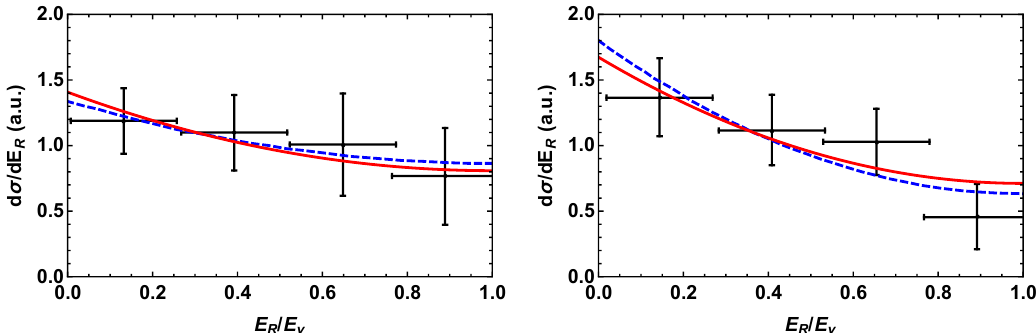
Figure 2 . The differential cross sections of the ν µ (left) and ¯ ν µ (right) scattering on electrons at CHARM-II. The black data points and the blue dashed SM prediction curve are taken from ref. [23]. The red curve corresponds to our best-fit prediction in the